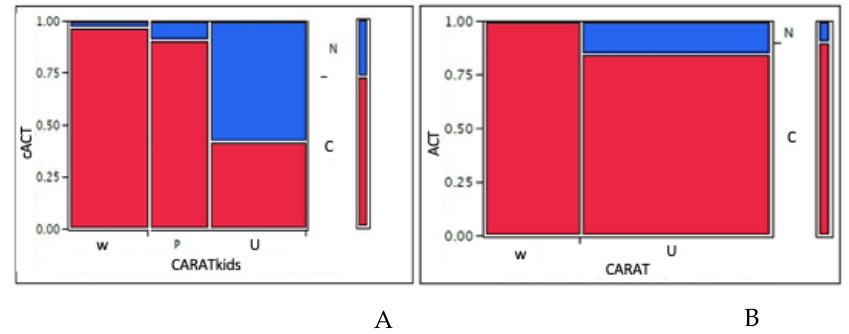
Figure 3. ( A ): comparison between cACT grades and CARATkids grades in children; ( B ): comparison between ACT grades and CARAT grades in adolescents. W = well-controlled asthma; P = partly-controlled; U = uncontrolled according to GINA classification. N = not controlled; C = controlled according with CARAT / CARATkids. A 1 value means 100% consistency between tests. X square